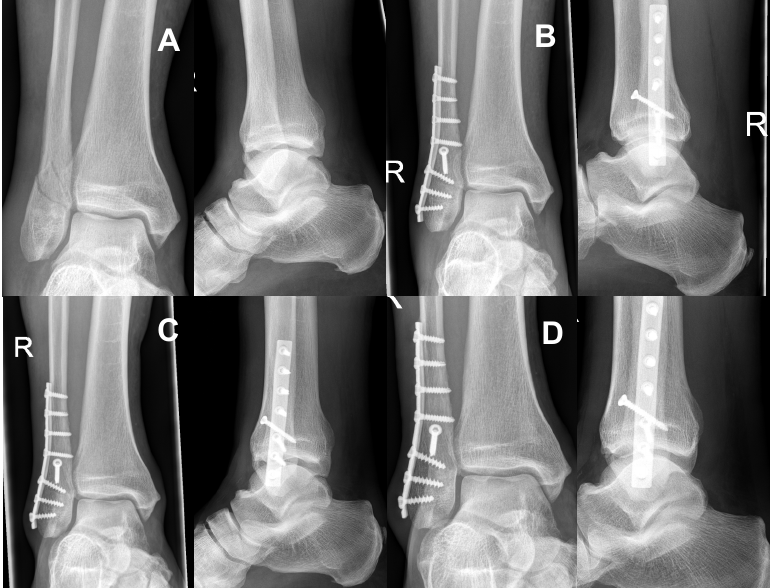
Figure 8. ( A ) shows the preoperative radiograph of a 72-year-old male patient with an AO type 44B1.1 fracture. The patient was treated with the DePuy Synthes ® one-third semi tubular plate system. Figure ( B ) presents the postoperative results after 6 and Figure ( C ) after 12 weeks. In addition, the 14 months postoperative control ( D ) shows good fracture healing without any secondary complications.